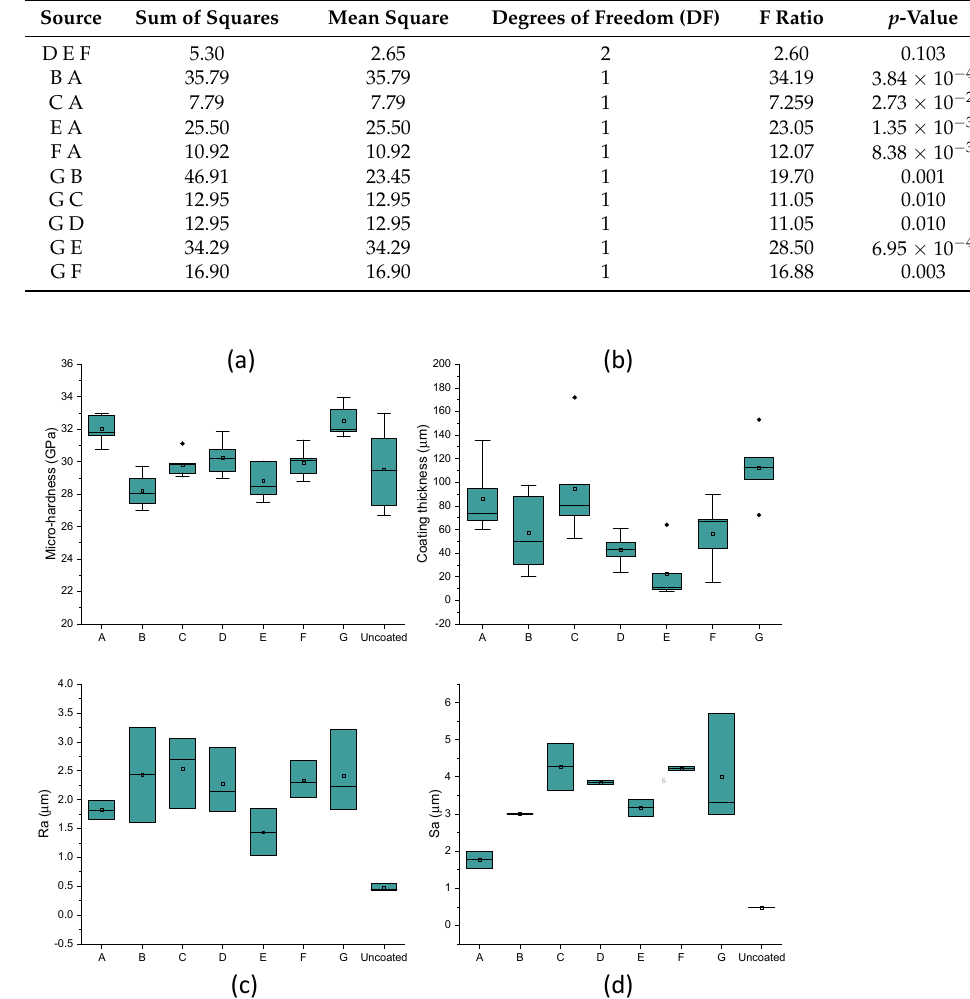
Figure 2. ( a ) Micro-hardness measurements for coated and uncoated samples, ( b ) coating thickness variation post-process, ( c ) boxplot of two-dimensional (2D) surface roughness (Ra) for coated and uncoated samples, ( d ) boxplot of 3D surface roughness (Sa) for coated and uncoated samples.